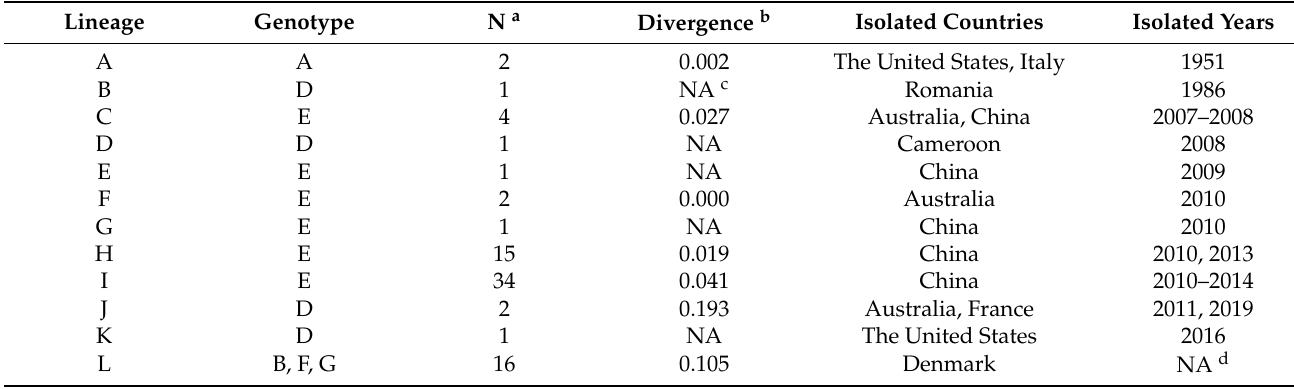
Table 2. Information on global CVB4 evolutionary